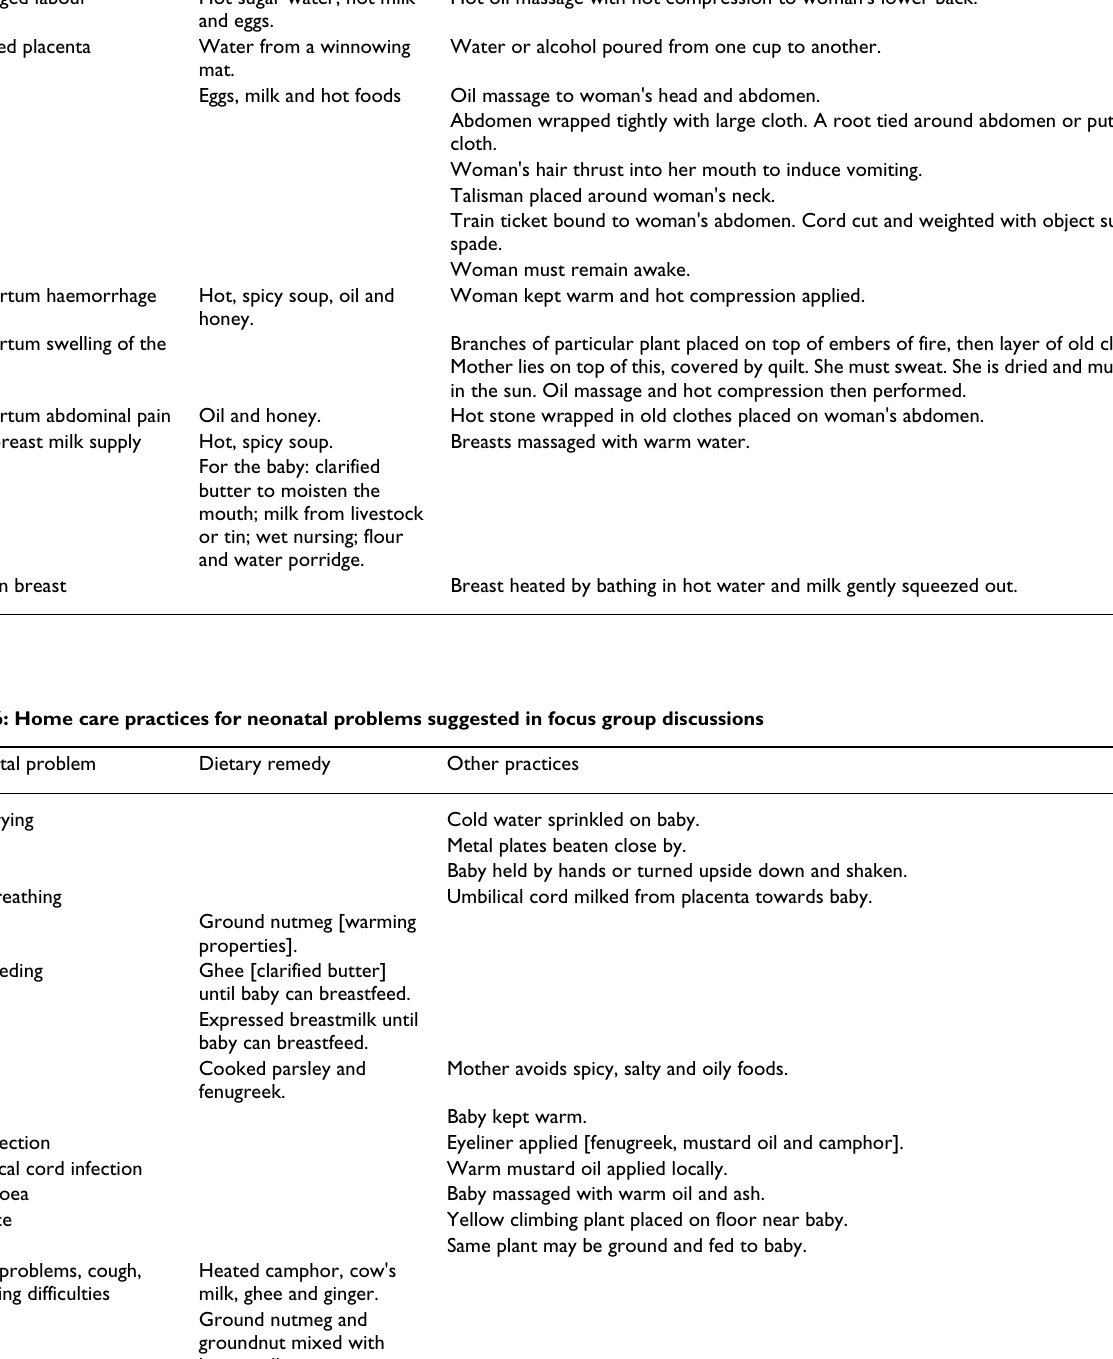
Table 5: Home care practices for maternal problems suggested in focus group discussions Maternal problem Dietary remedy Other practices Antepartum haemorrhage